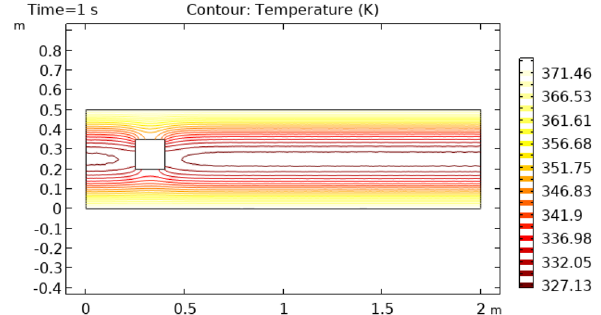
Figure 15. Contour temperature in squared cylindrical flow at t = 5 s.